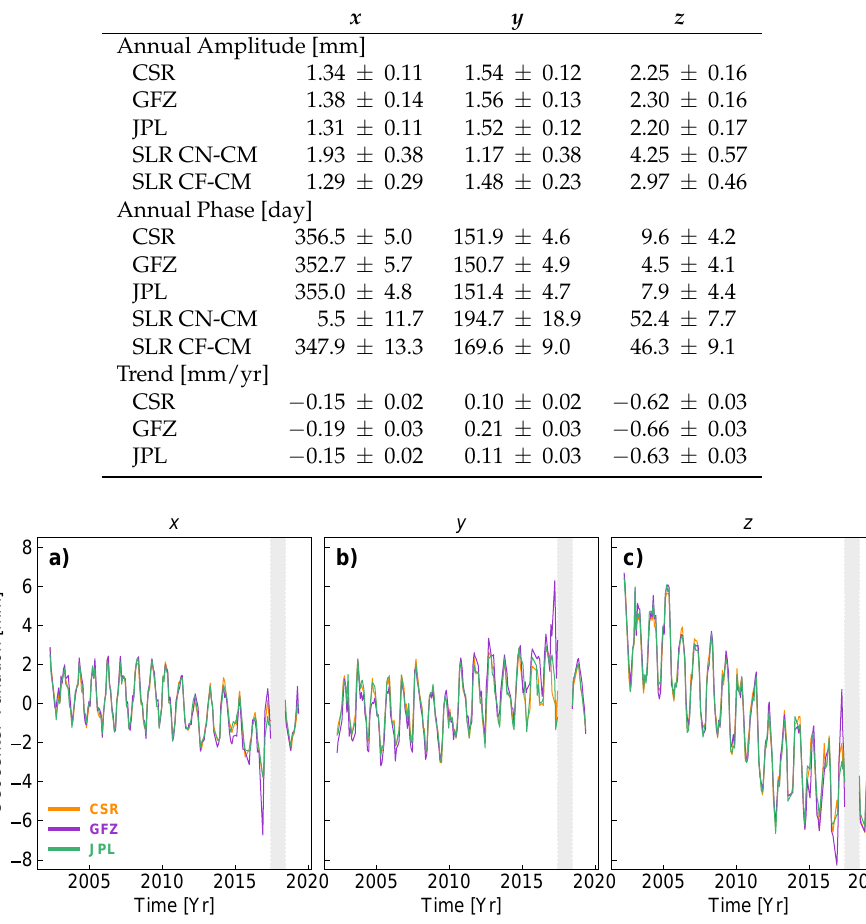
Figure 5. Time series of recovered geocenter variations, ( a ) x , ( b ) y and ( c ) z , in mm calculated using an iterated self-consistent geocenter with self-attraction and loading effects from time-variable gravity fields provided by the Center for Space Research (orange), the German Research Centre for Geosciences (purple) and the Jet Propulsion Laboratory (green). The gray shading denotes the period between the GRACE and GRACE-FO missions.